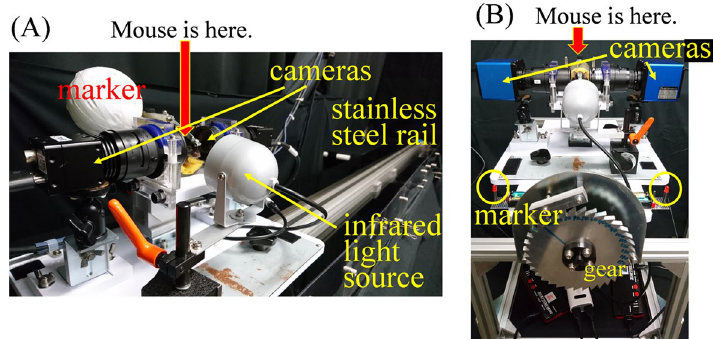
Figure 5. Equipment. ( A ) The stainless steel rail and sled for the stimulation of linear translation. This setting was used for the recording of eye movement during translational motion in dark conditions. Infrared high- speed cameras were set immediately beside the mouse. ( B ) The gear and container for the stimulation of static tilt in dark conditions. Infrared cameras were set immediately beside the